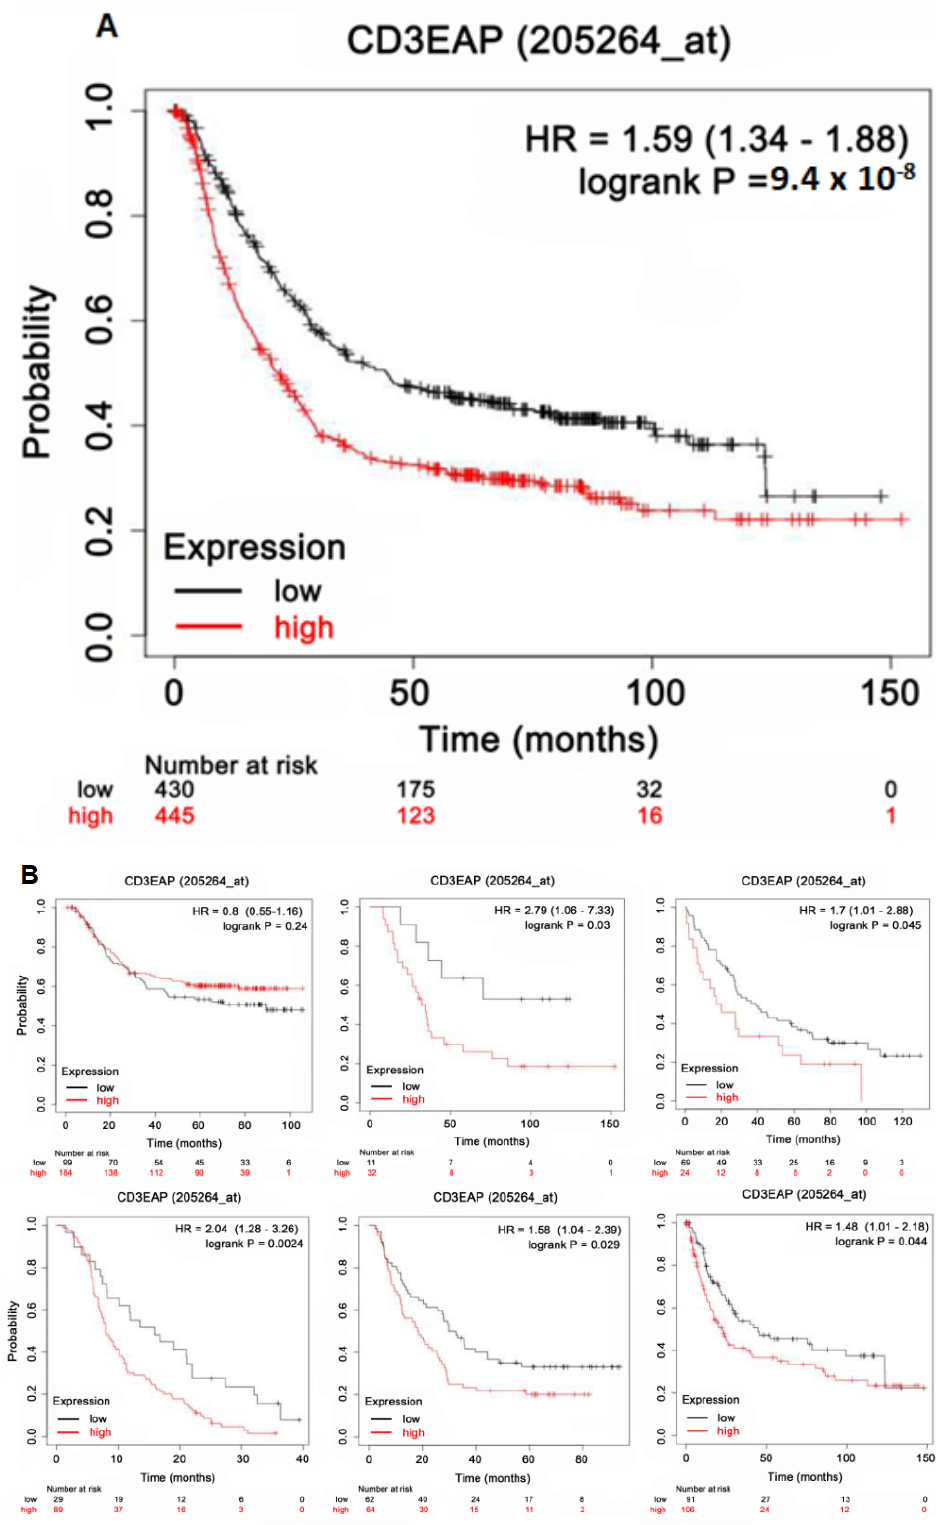
Figure 4. ( A ) All. High CAST expression versus low CAST expression in patients with GC. ( B ) Subgroup survival analyses. High CAST expression versus low CAST expression in patients with GC.